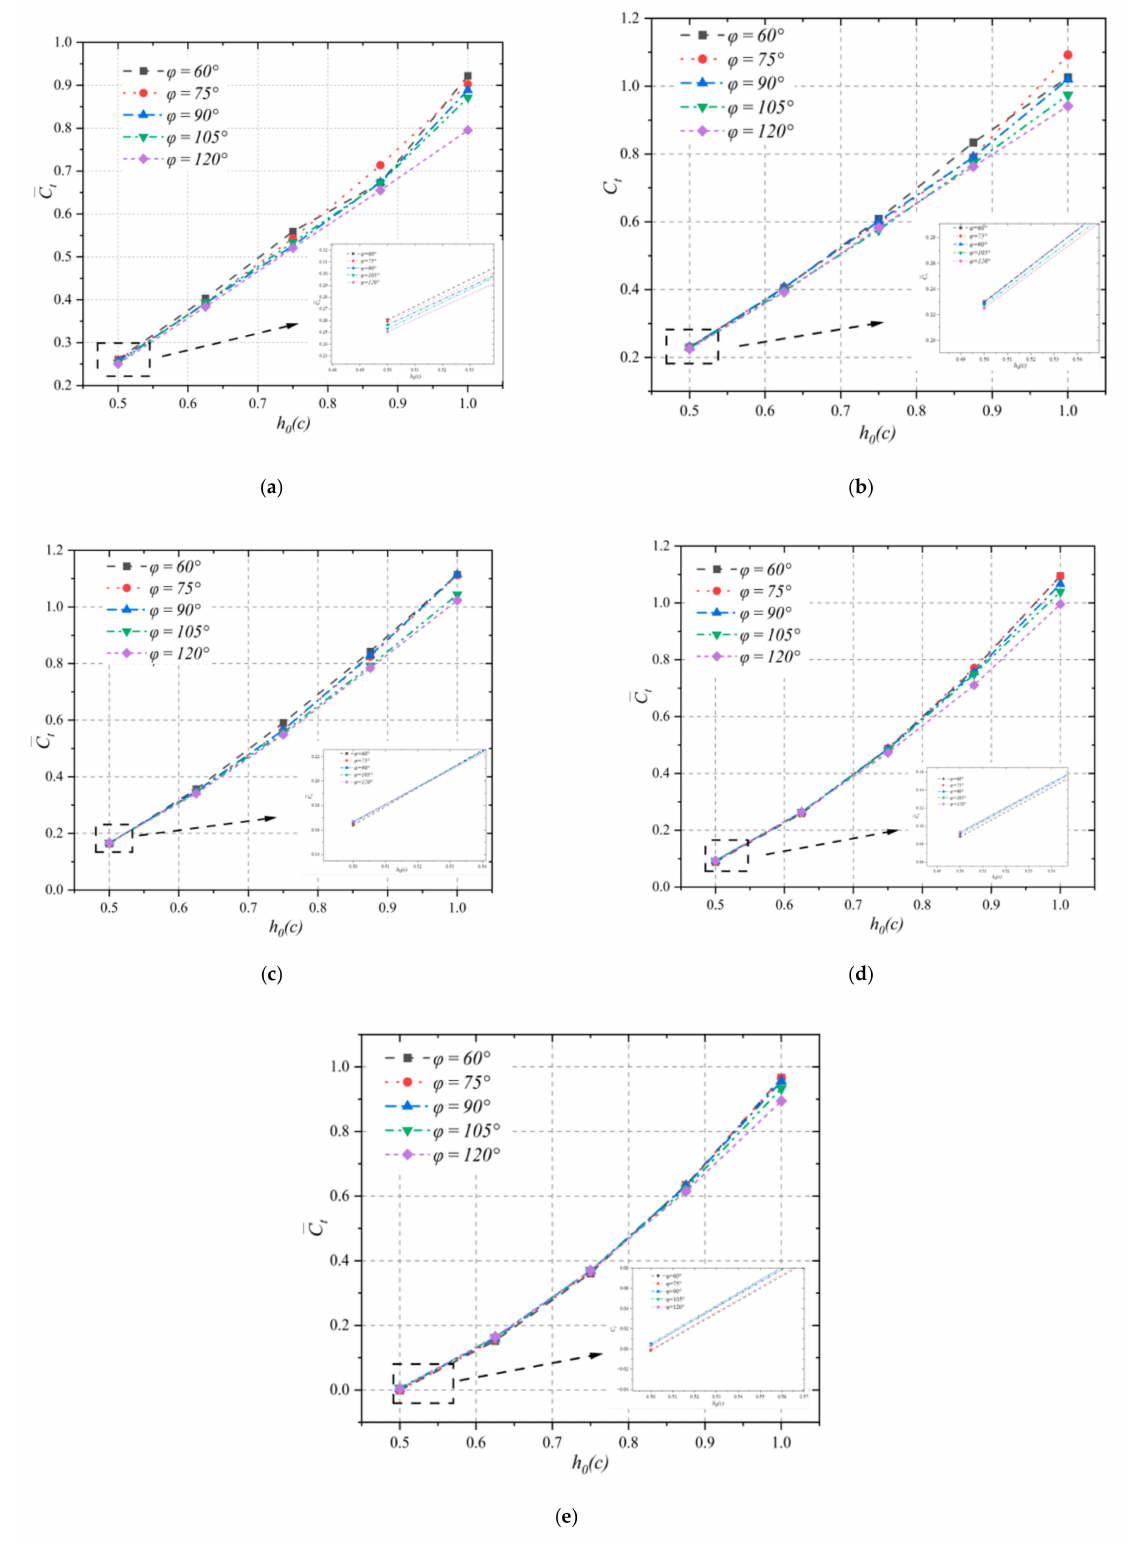
Figure 8. Variation of average thrust coefficient with amplitude under different pitch amplitudes